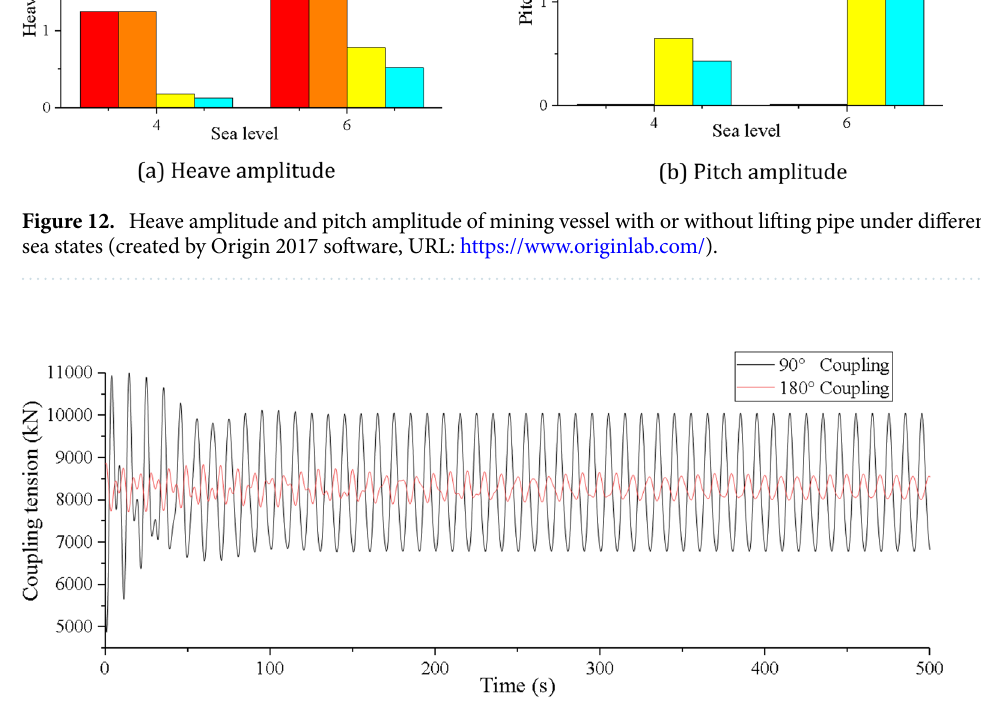
Figure 13. Time history of coupling tension under level 6 sea state on OrcaFlex (created by Origin 2017 software, URL: https:// www. origi nlab.